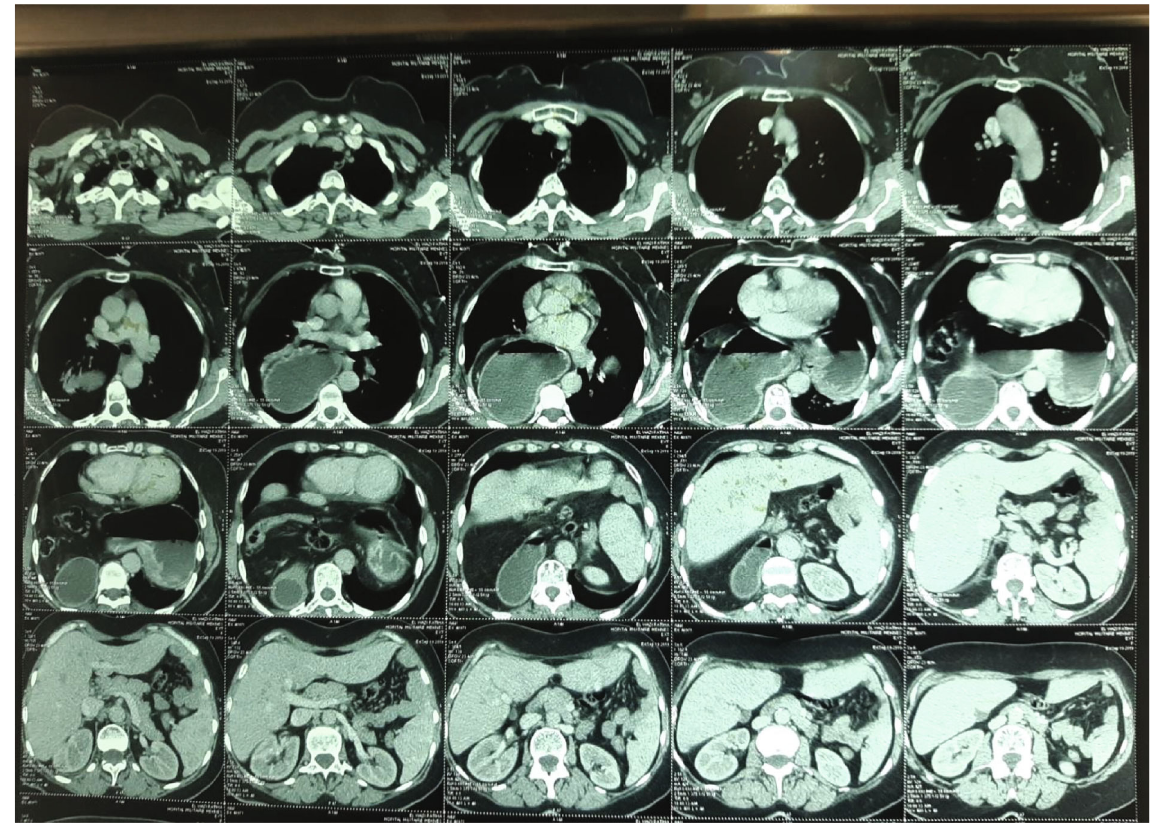
Figure 1: A thoracoabdominal CT scan showing a stomach stasis on a pyloric